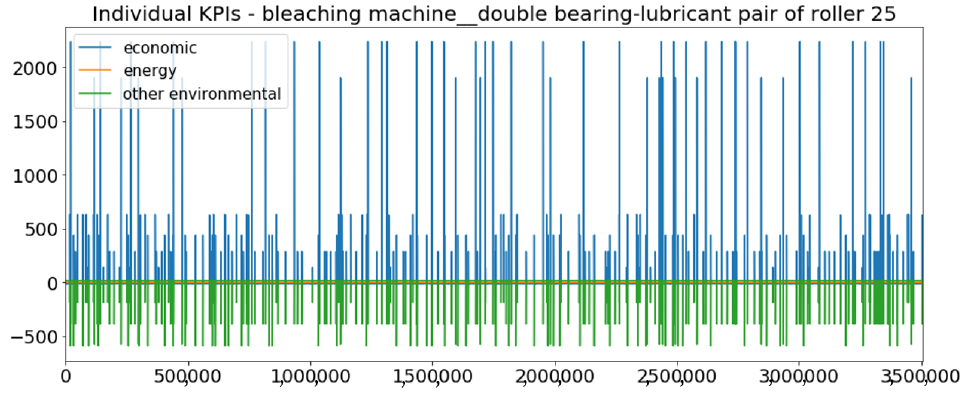
Figure 21. Individual KPI time series for the double bearing-lubricant pair yielded from running the model with standalone uncoated roller for the bleaching machine (ZORLUTEKS). The simulation interval has the same length as for training (200